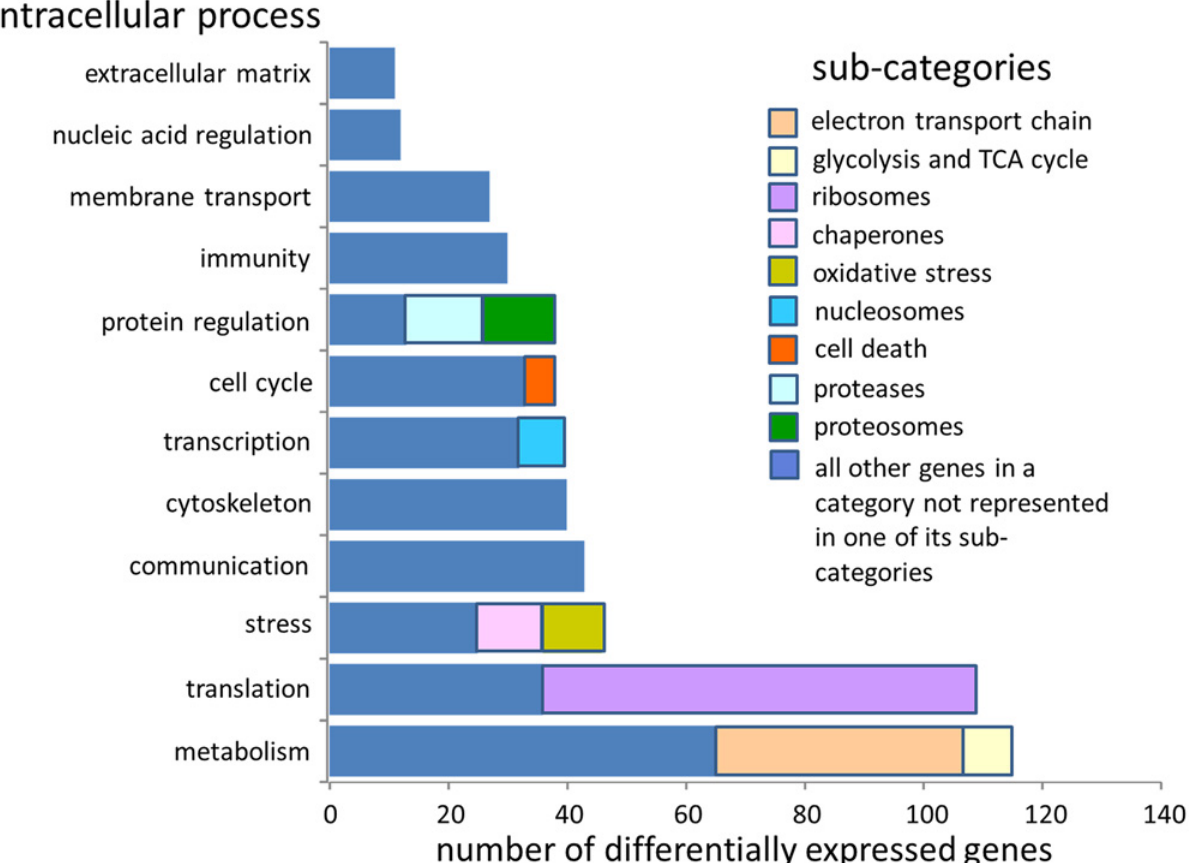
Fig 2. The number of differentially expressed genes from all environmental treatments that fell into discrete intracellular process